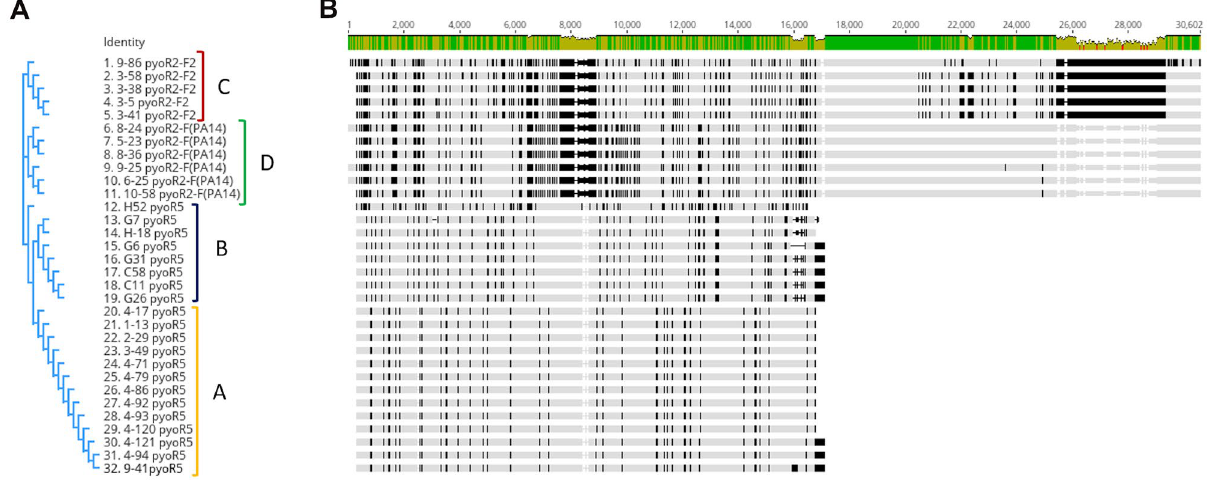
Figure 3. Similarity study of the 32 pyocin clusters identified and its relation with the established groups. ( A ) Phylogenetic tree. ( B ) Alignment of the 32 pyocins clusters.